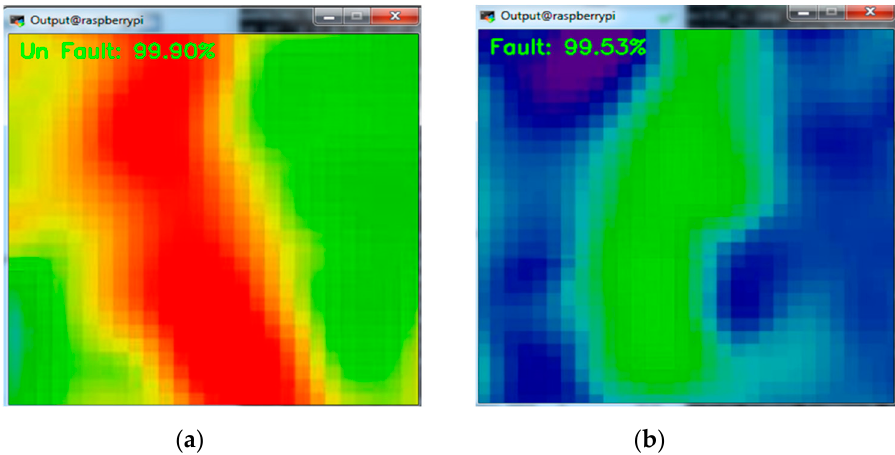
Figure 2. The output of a CNN-based decision support system on input thermal test imaged: ( a ) Un-faulty condition; ( b ) Faulty